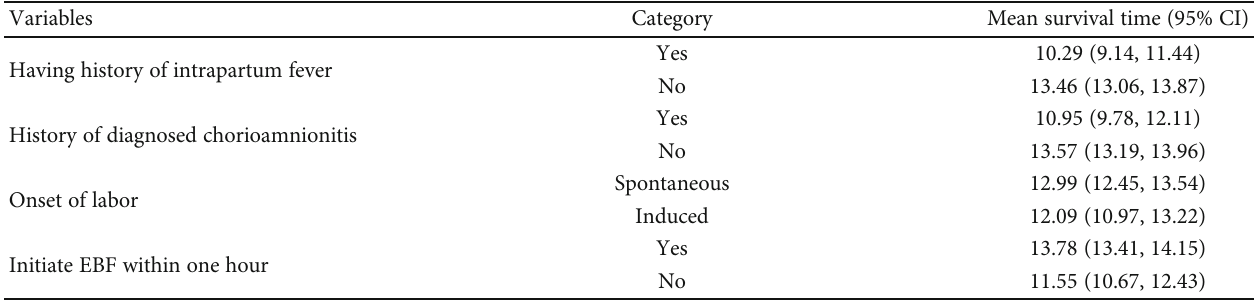
Table 5: The mean survival time and corresponding 95% CI among the covariates of predictors of mortality among neonates with neonatal sepsis.